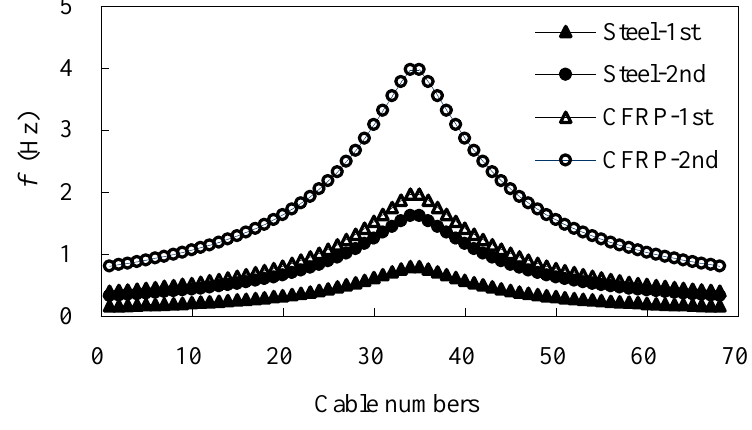
Figure 6. Natural frequencies of steel and CFRP cables.